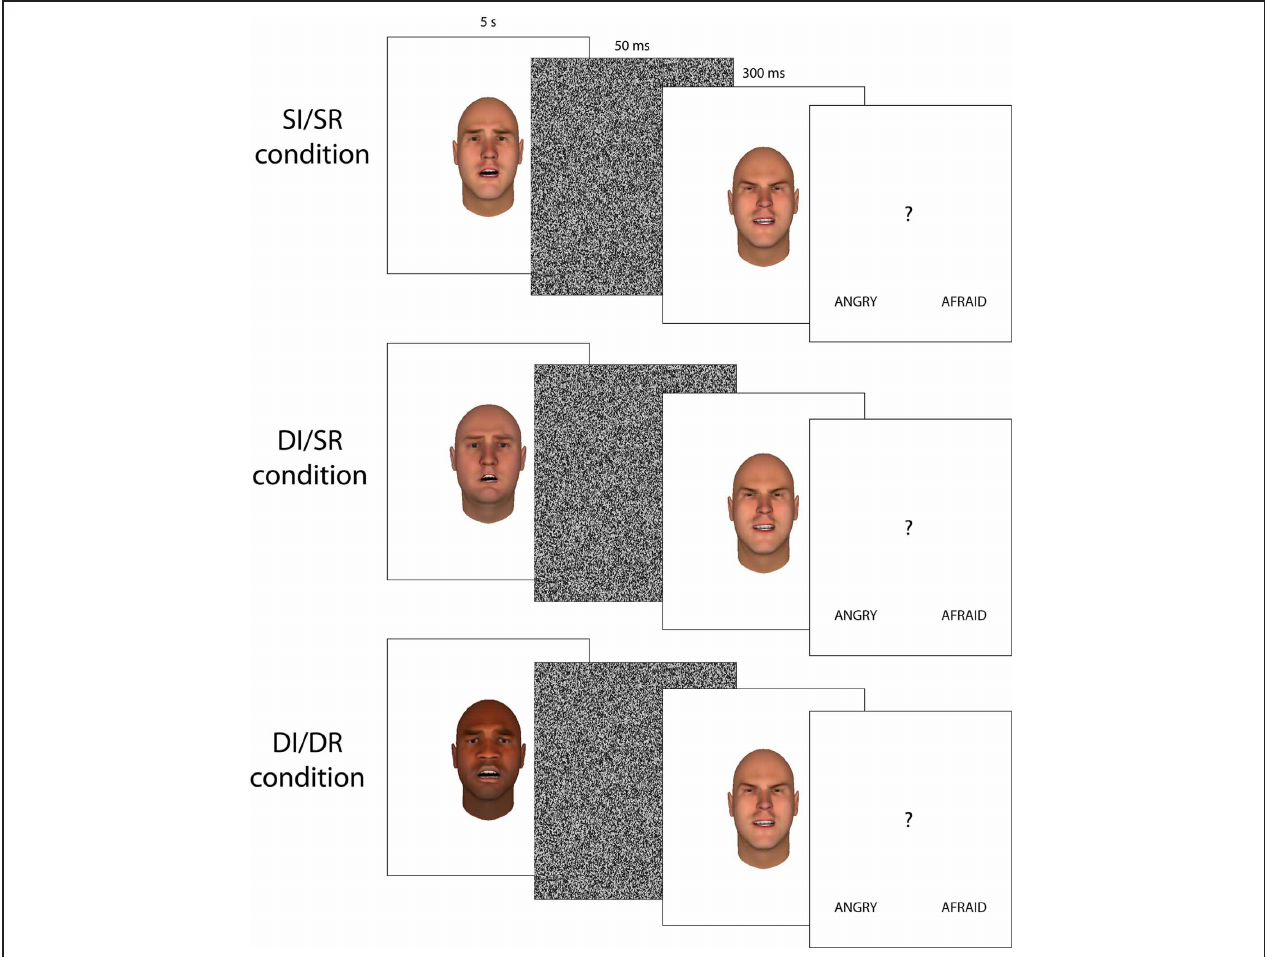
FIGURE 1 | Examples of the three different trial types used in Experiment 1 and 2 (faces were identical to experiment 1, but presented in gray